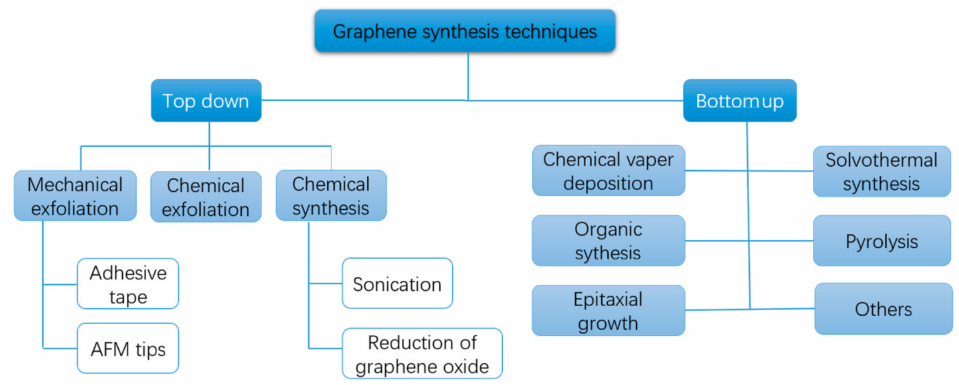
Figure 6. The synthesis method of